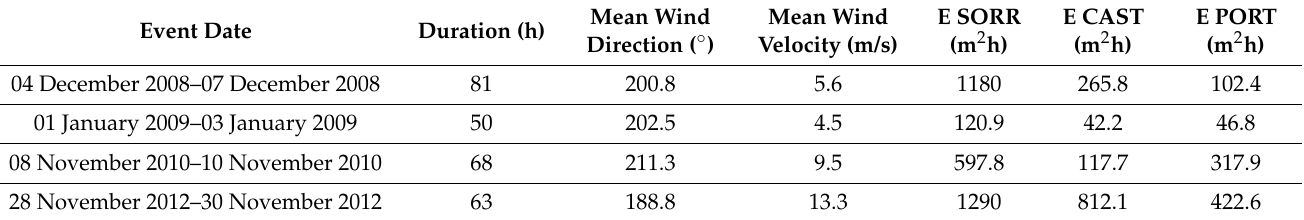
Table 2. Main parameters of sea storms